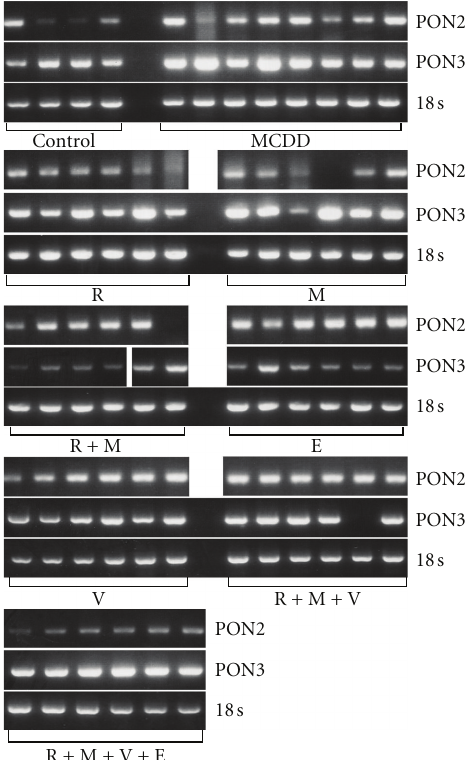
Figure 3: PON2 and PON3 mRNA expression in rat fatty liver experimental model. Fatty liver in Sprague-Dawley rats was induced by methionine-choline-deficient diet (MCDD) for 9 weeks. Rats were treated for other 6 weeks with rosiglitazone (R); metformin (M); rosiglitazone + metformin in combination (R+M); ezetimibe (E); valsartan (V); rosiglitazone + metformin + valsartan in combination (R+M+V) or rosiglitazone + metformin + valsartan + ezetimibe (R+M+V+E). 18s ribosomal RNA was used for relative quantification. “ # ” indicates P < 0 . 05 versus control group (fed by standard rat chow). “ ∗ ” indicates P < 0 . 05 versus MCDD